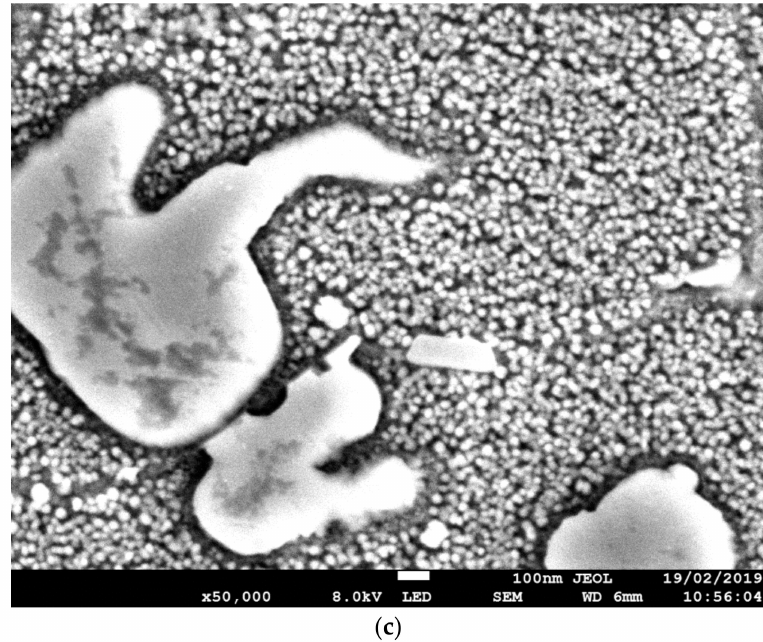
Figure 5. ( a ) FEG SEM image approximately 3 mm from the bondline, ( b ) FEG SEM image approximately 1 mm from the bondline, and ( c ) FEG SEM image approximately 1 mm from the bondline.